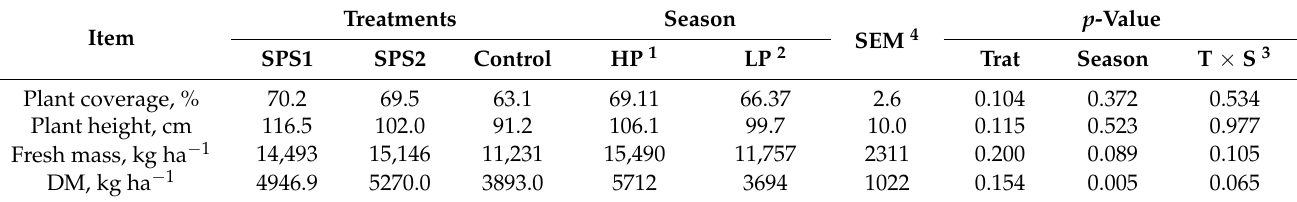
Table 1. Agronomic measurements and forage production of guinea grass Panicum maximum cv. Mombaça in the different silvopastoral